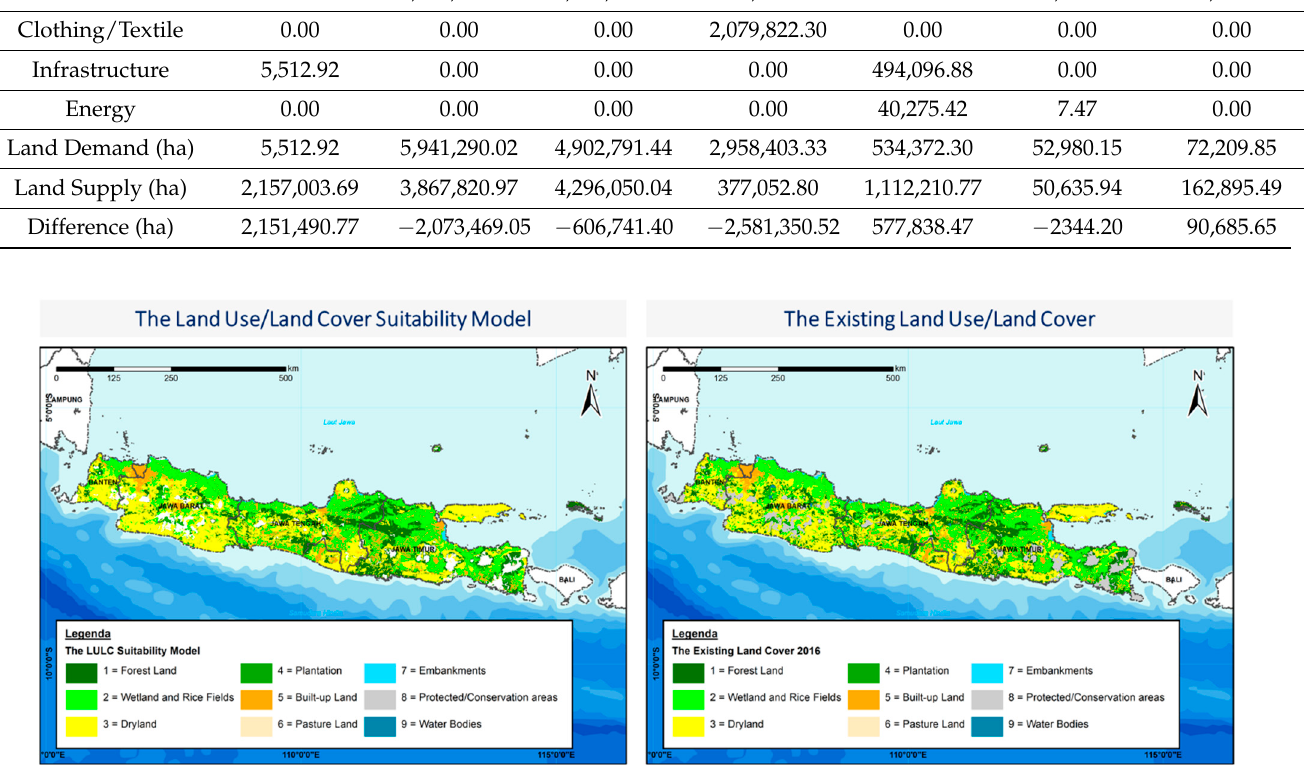
Figure 7. Comparison of land suitability model with existing conditions (the year 2016).